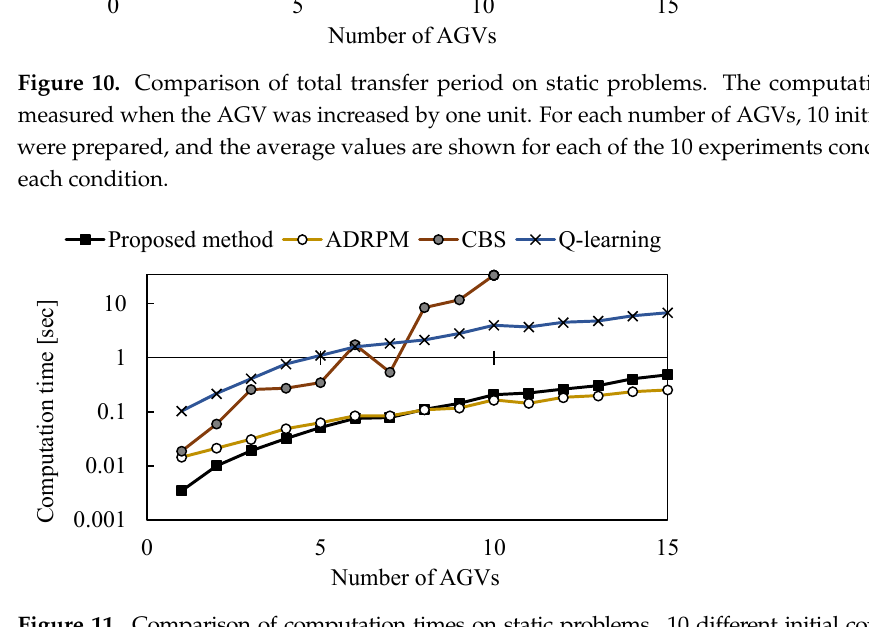
Figure 11. Comparison of computation times on static problems. 10 different initial conditions were prepared at each number of AGVs, and the average of the 10 times under each initial condition was